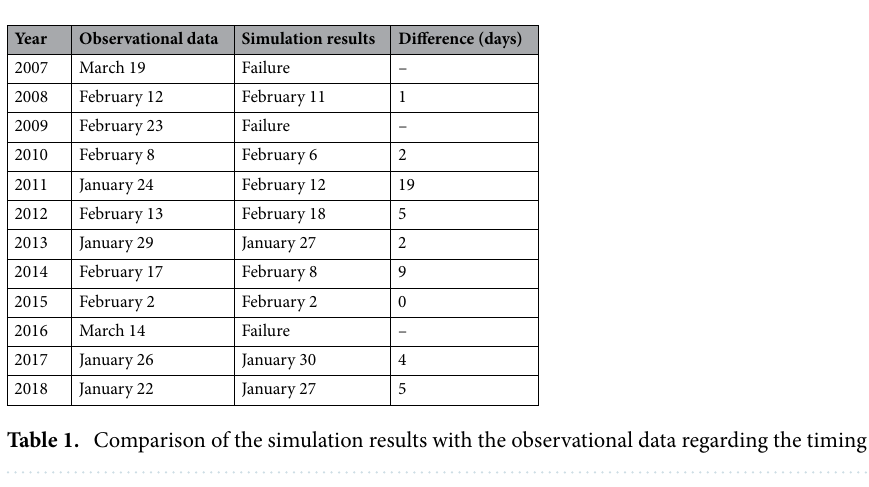
Figure 2. The simulated time variations in the timing of turnover in Lake Biwa from 2008 to 2018. Dots show the value of turnover timing, and dashed lines represent the failure of turnover. A fitting curve (the blue line) exhibits general change trends with a 95% confidence interval.